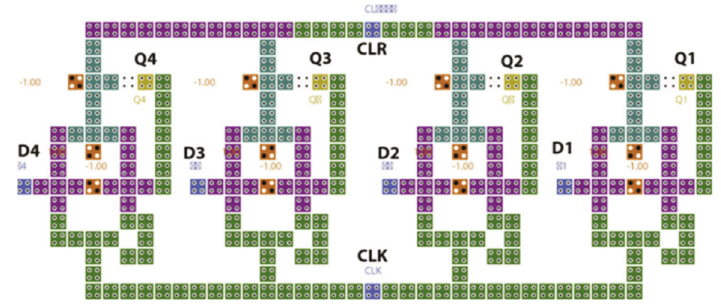
Figure 6. 4-bit PIPO shift register from [30] .